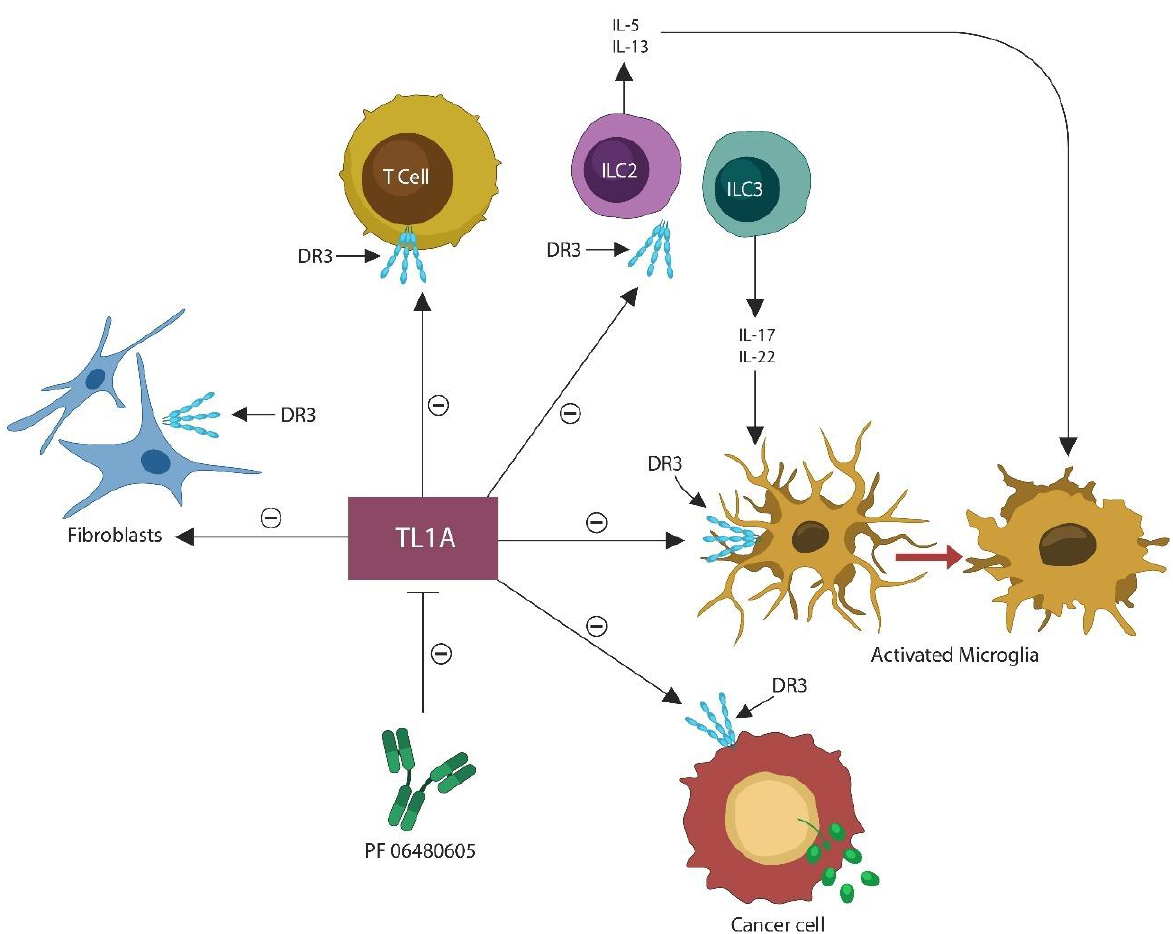
Figure 3. TL1A, a T cell co-stimulator, also stimulates other DR3-expressing cells, including ILC2, ILC3, fibroblasts, cancer cells, and microphages, including the brain macrophages, and microglia. This places TL1A at the center of the disorders of uncertain etiology, while its inhibition likely diminishes this pathology. Activated microglia often engages in the elimination of viable neurons, contributing to neurodegeneration. Anti-TL1A antibody, PF-06480605 blocks TL1A, inhibiting the stimulatory effect on these systems, and thus decreasing the incidence of idiopathic